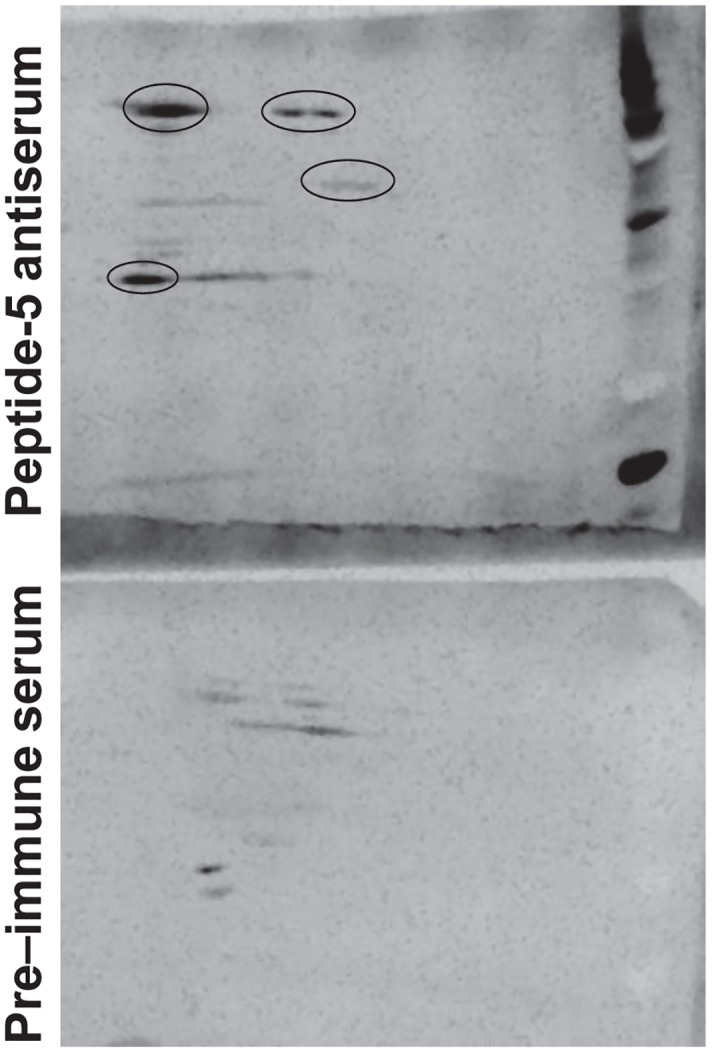
Anti-peptide 5 serum recognizes four unique A. baumannii cell surface proteins.Cell surface proteins of XDR A. baumannii HUMC1 were separated on a 2D gel and western blot was carried out using serum from rabbits immunized with Hyr1p peptide #5 antigen. Serum from the same rabbit prior to immunization was used as a control (pre-immune serum). Notice the four spots (circles) recognized by the immune serum vs. the pre-immune serum.